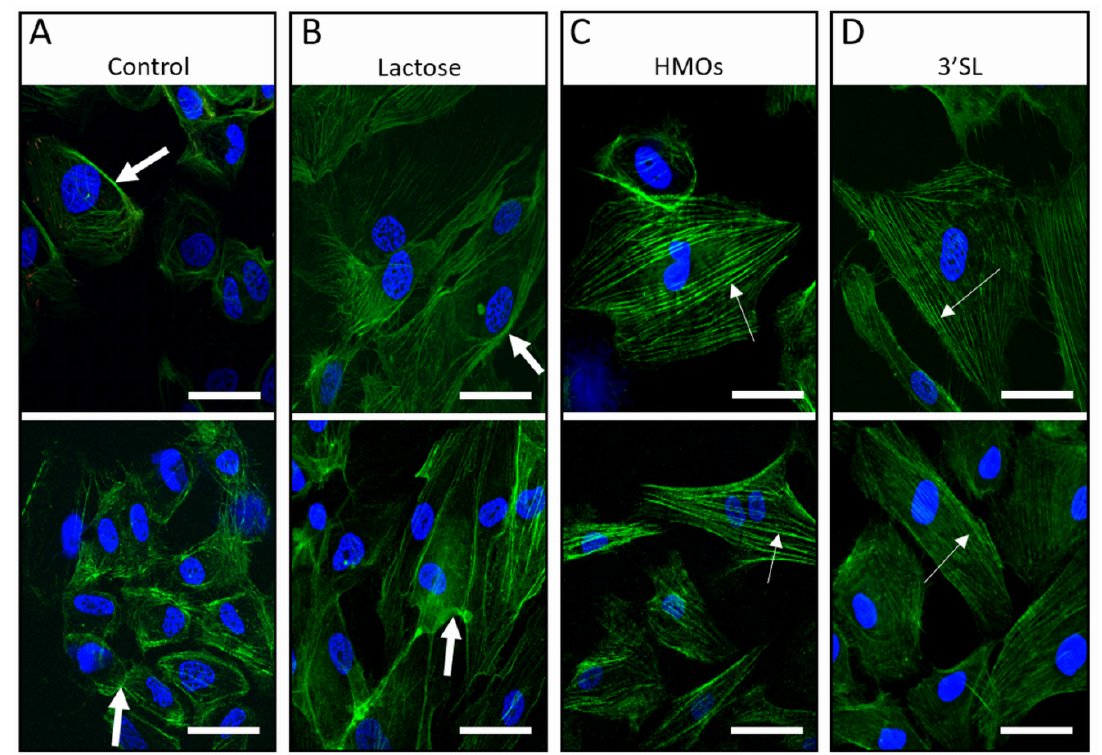
Figure 4. Effect of HMOs on actin cytoskeleton organization of cultured fpECs. The 5 × 10 4 cells per well were seeded on gelatin coated chamber slides. fpECs were cultured for 24 h in M199 medium containing 10% hPS and 10% nBCS followed by a treatment of 24 with M199 medium containing HMOs, 3 ′ SL or lactose, or left untreated (two representative images each). ( A ) Control conditions (untreated cells) and ( B ) cells treated with lactose as non-HMO showed membrane ruffle formation (big white arrows) and weak phalloidin staining. Treatment with ( C ) HMOs ( D ) 3 ′ SL led to parallel, highly ordered and strongly stained stress fibers (thin white arrows), similar to the positive pro-angiogenic control with TVF (TNF- α , VEGF and FGF-2) (not shown). There was no difference between the 24- and 48-h treatments. Similar results were obtained in five individual experiments with different fpEC isolations ( n = 5). 3 ′ SL, 3 ′ -sialyllactose; scale bar = 50 µm.